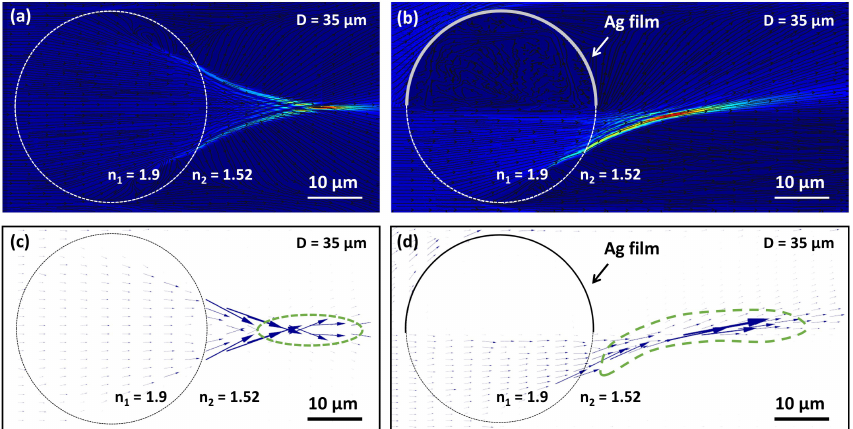
Figure 2. ( a ) PJ formed by a 35 µ m-diameter pristine BTG microcylinder immersed in MIO; ( b ) PH formed by a 35 µ m-diameter patchy BTG microcylinder immersed in MIO; ( c , d ) Corresponding Poynting vector of ( c ) the pristine microcylinder and ( d ) the patchy